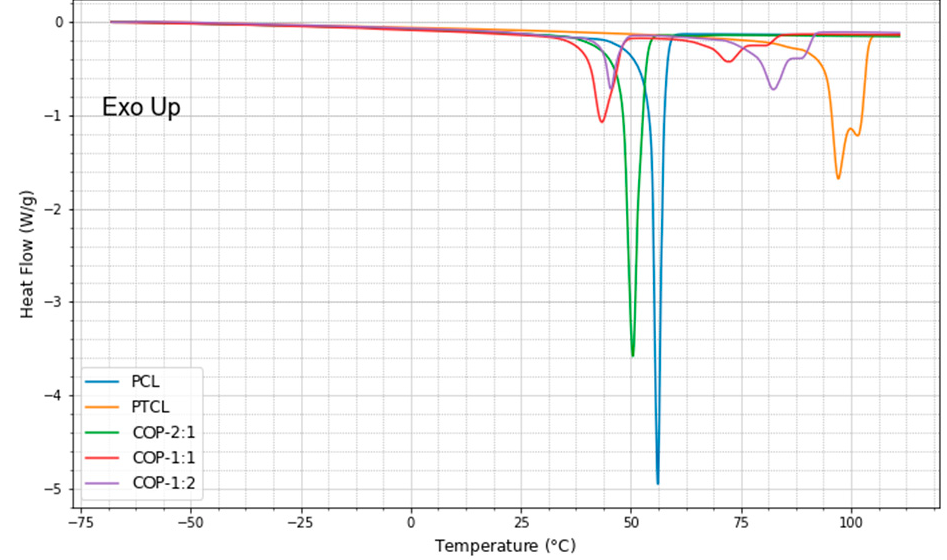
Figure 4. DSC thermograms of PCL, PTCL, and COP copolymers 2:1, 1:1, and 1:2 (exothermic signals